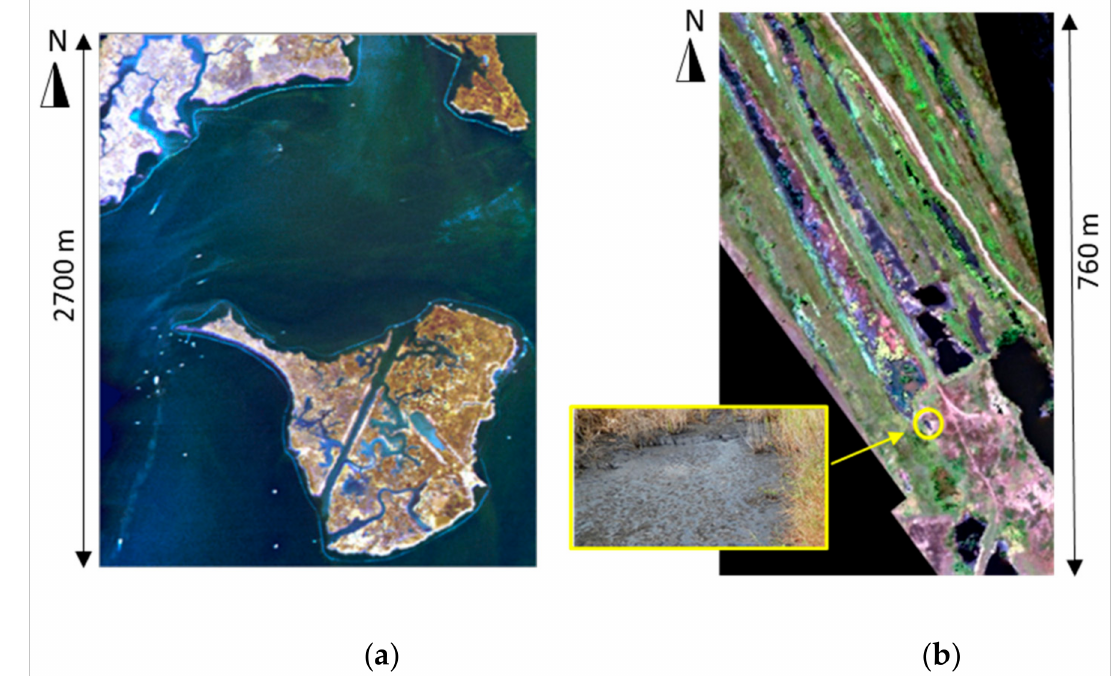
Figure 3. ( a ) RGB Airborne Visible/InfraRed Imaging Spectrometer (AVIRIS) image over Bay Jimmy; ( b ) RGB HySpex image over the tar pit (yellow outline) and a picture of the tar